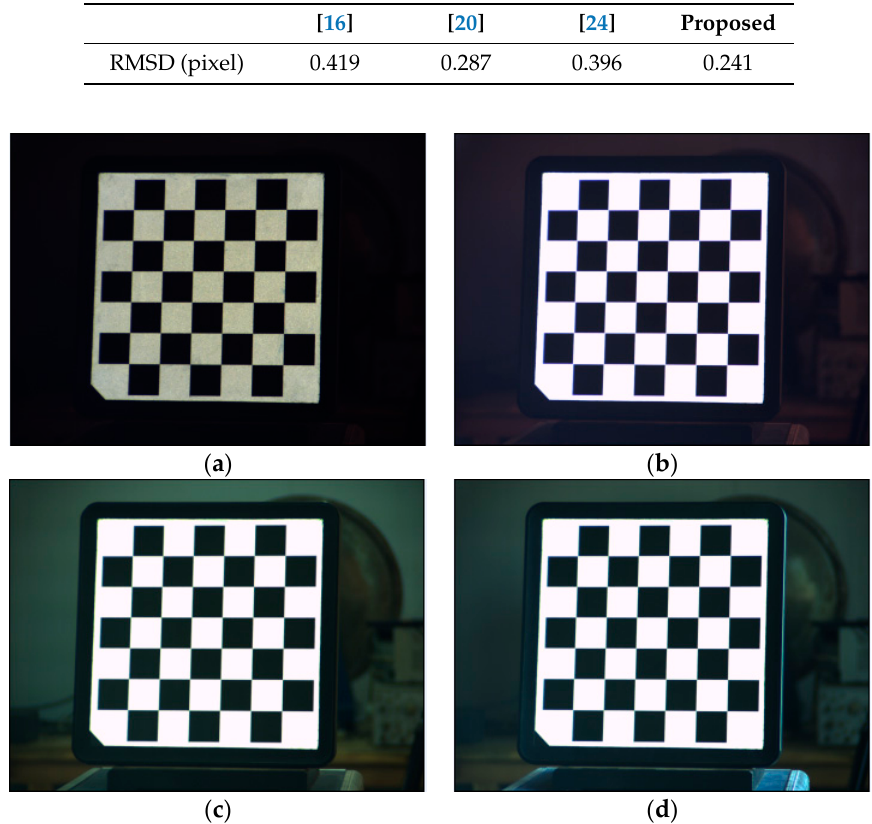
Figure 15. Four images of a stationary chessboard captured under ( a ) underexposed, ( b ) overexposed, ( c ) indoor light interfered, and ( d ) outdoor light interfered scenarios.